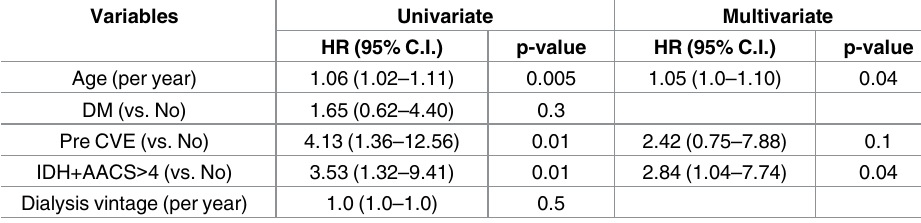
Table 4. Cox proportional hazard models for risk factors of new